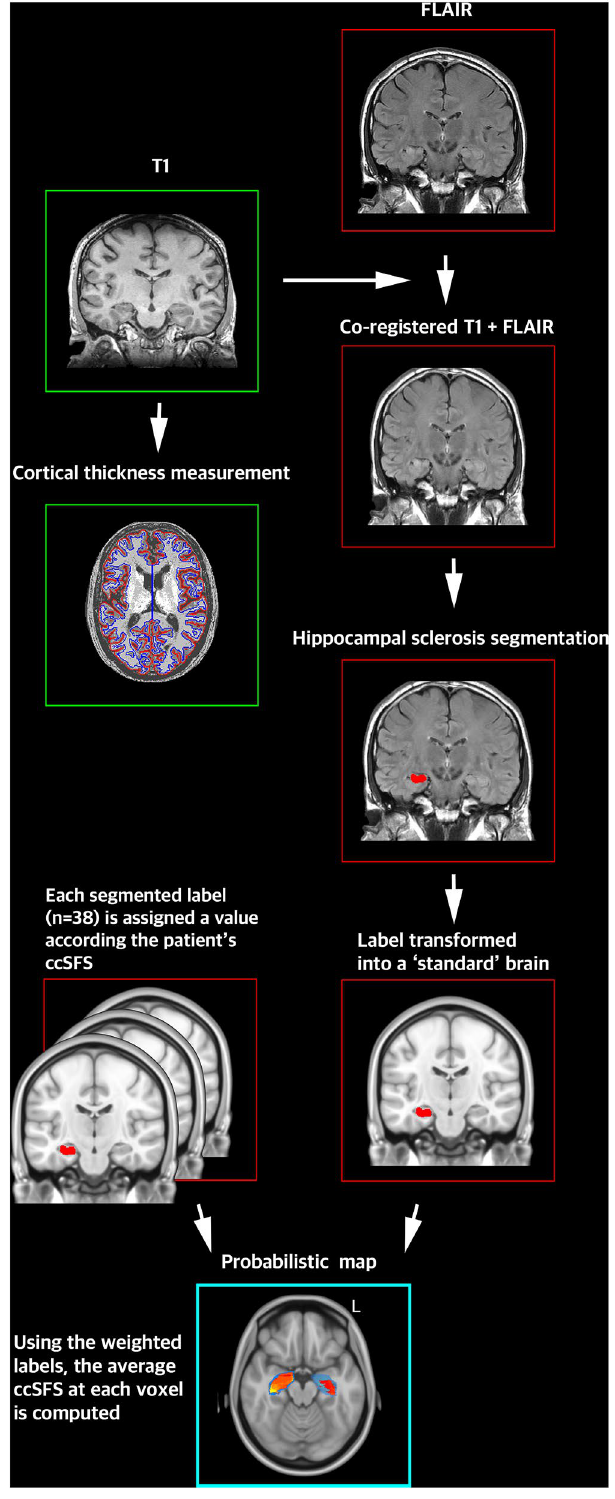
Figure 1. Summary of methods. For each patient, a T1 sequence and FLAIR sequence were co-registered. Using the co-registered T1 + FLAIR, areas of hippocampal hyperintensity—corresponding to hippocampal sclerosis—were segmented. The resulting label was transformed into ’standard’ space, in order to facilitate group level analysis. This process was completed for all 38 patients, resulting in 38 labels. Each label was assigned a value according to each patient’s ccSFS. Using all 38 weighted labels, the average ccSFS at each voxel was computed in the ’standard brain’, producing the probabilistic map. Cortical thickness for each patient was computed using their T1 images, using the program CIVET. ccSFS Cleveland Clinic seizure freedom score, FLAIR fluid attenuated inversion recovery, T1 T1